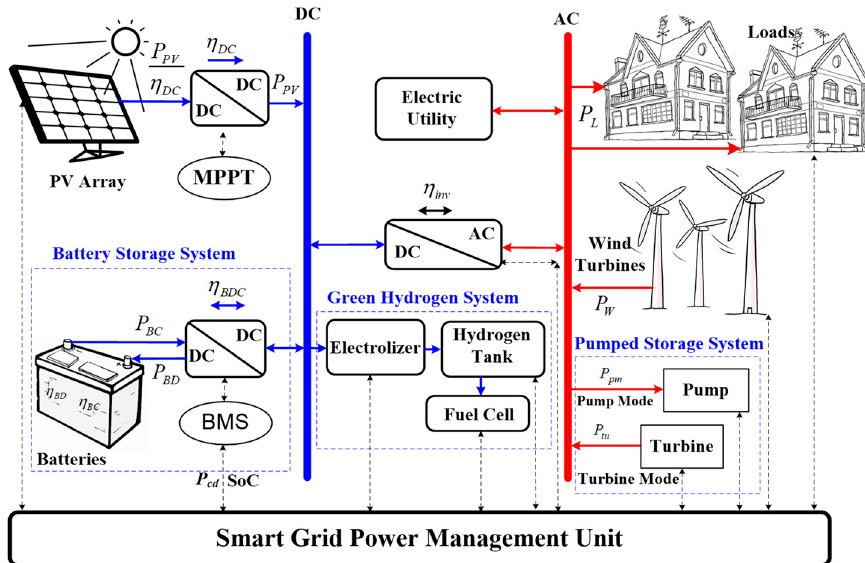
Figure 3. The connection of the proposed HRES.